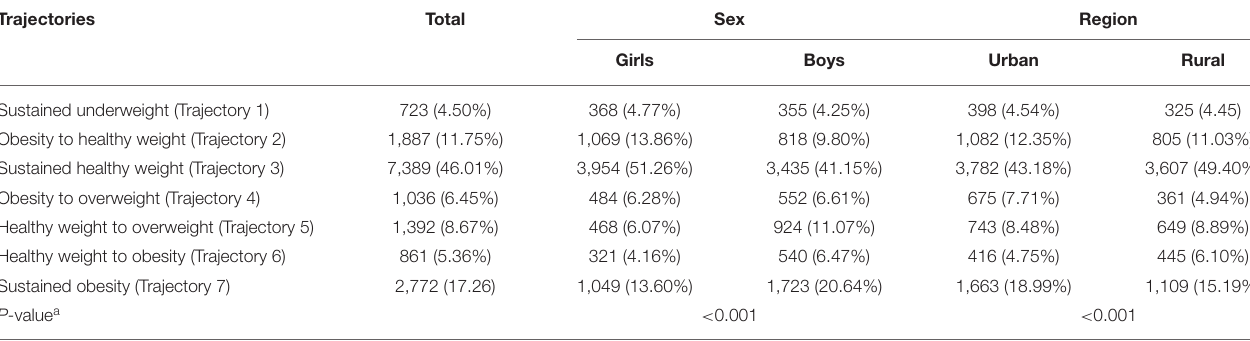
FIGURE 1 | Trajectories of body shape during children from 6 to 11 years. Solid lines represent observed values, and dashed lines represent expected values. Trajectory 1, “sustained underweight” (4.50%); Trajectory 2, “obesity to healthy weight” (11.75%); Trajectory 3, “sustained healthy weight” (46.01%); Trajectory 4, “obesity to overweight” (6.45%); Trajectory 5, “healthy weight to overweight” (8.67%); Trajectory 6, “healthy weight to obesity” (5.36%); Trajectory 7, “sustained obesity” (17.26%).